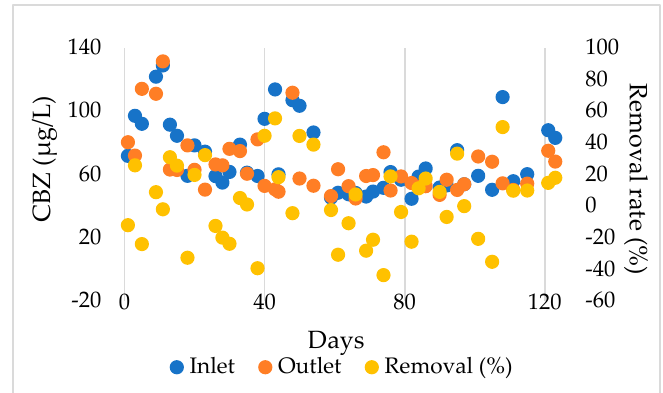
Figure 2. CBZ evolution in MBMBR system.